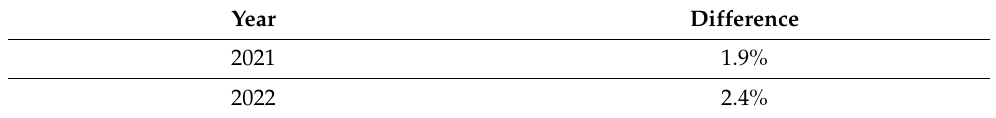
Table 3. The difference in forecasts between the adopted model and variant 2.